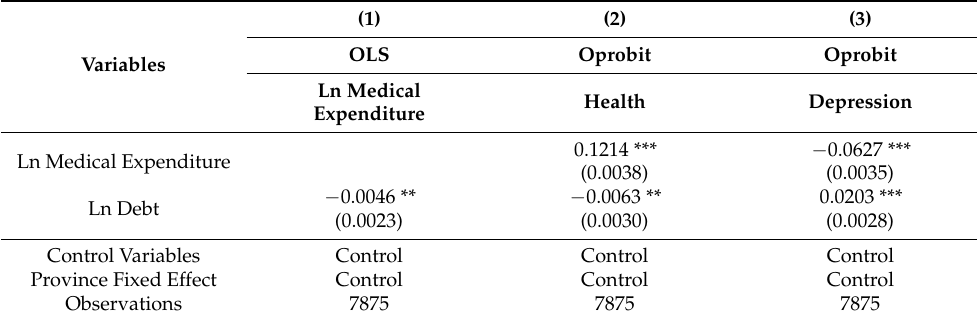
Table 12. Household debt, medical spending, and health of the